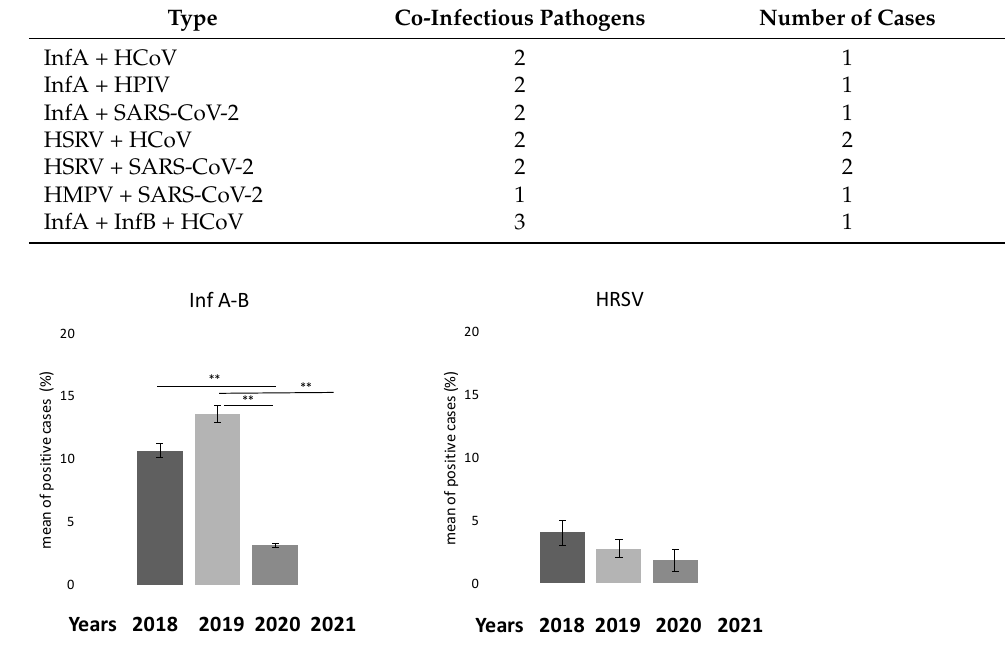
Table 3. Double and triple co-infections (October 2019–November 2021).